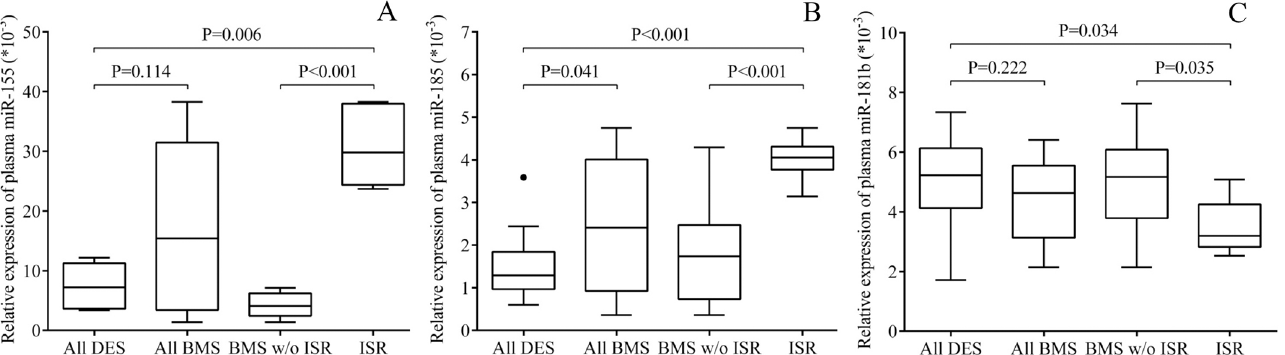
Fig 7. Quantification of circulating miR-155, miR-185 and miR-181b by RT-qPCR in plasma samples of BMS and DES patients. After total RNA isolation, the expression of circulating miRNAs was quantified in plasma samples by UPL-probe based stem-loop RT-qPCR assay. Plasma miR-155 (A) and miR-185 (B) were significantly upregulated in BMS patients with ISR compared to BMS and DES subjects without any complications, while miR-181b levels (C) were lower in those with ISR versus others without complication. (All DES: n = 21, all BMS: n = 28, ISR: n =